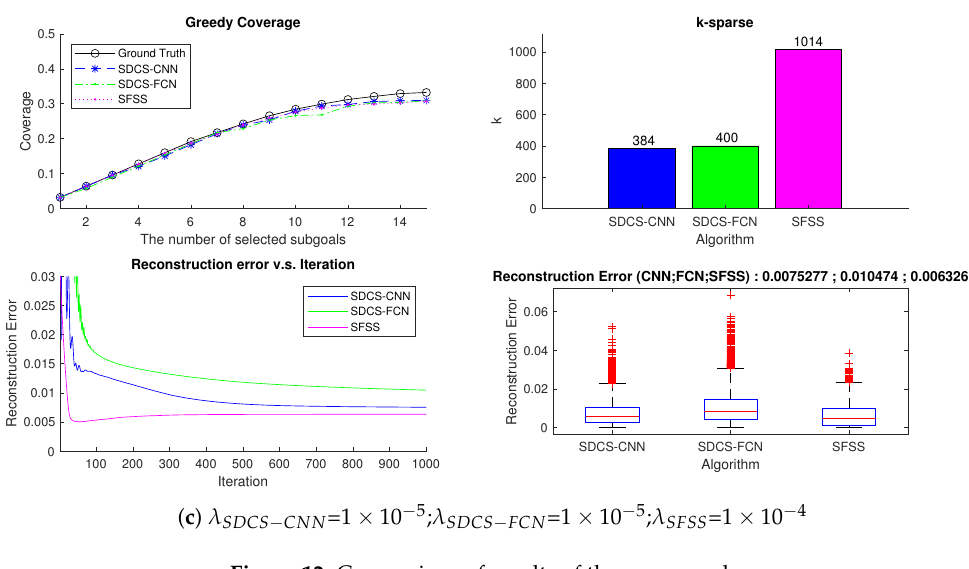
Figure 12. Comparison of results of three